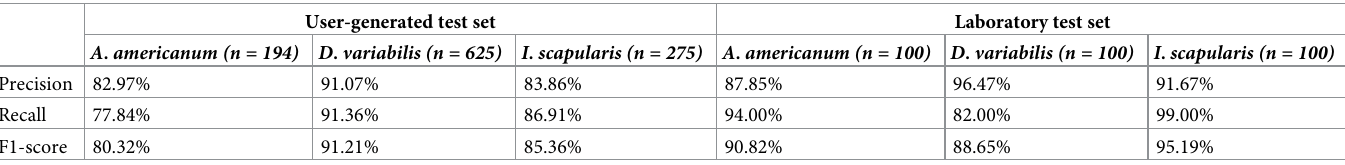
Table 3. Class-specific performance statistics of TickIDNet evaluated on the user-generated test set (n = 1094) and the laboratory test set (n =